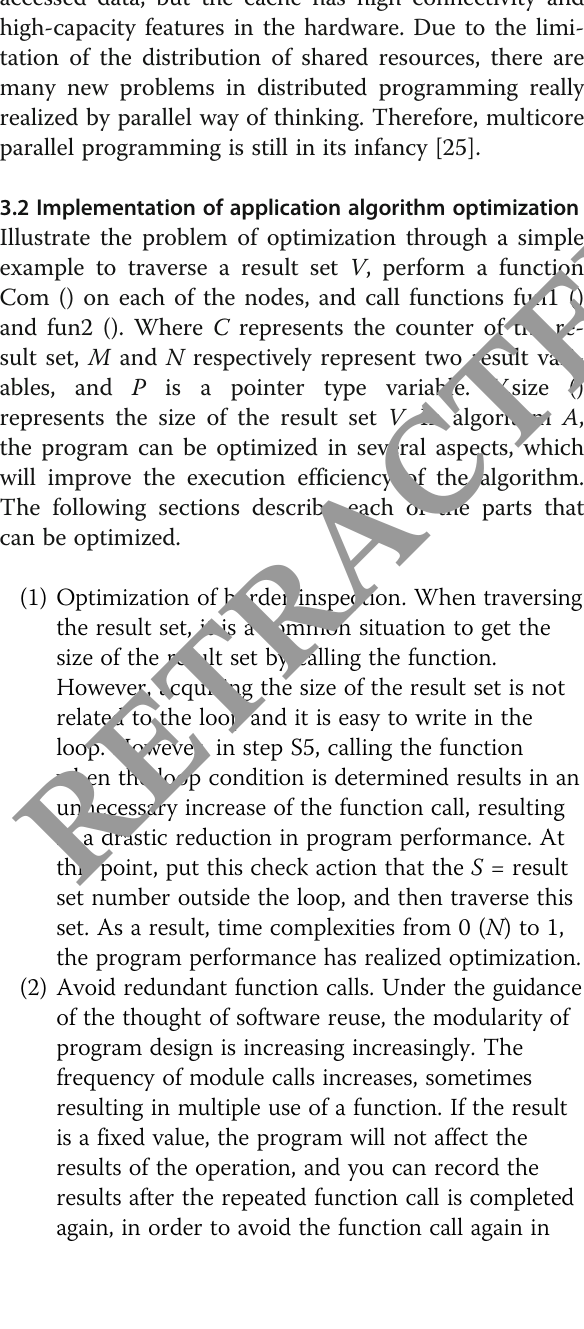
Algorithm B is modified to algorithm C by